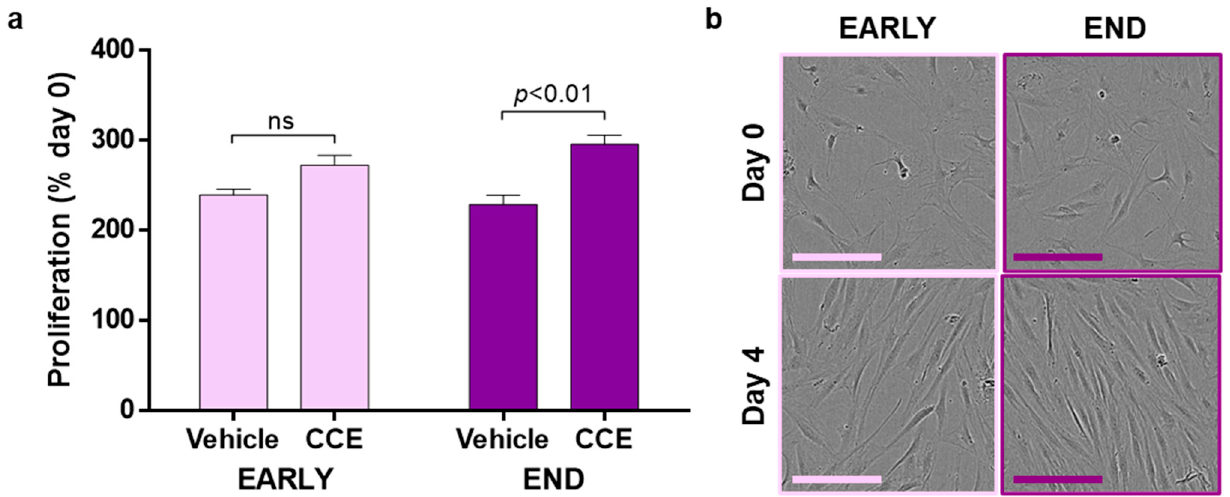
Figure 5. Paracrine modulation of hSMC proliferation. ( a ) CM from EARLY and END SMC were applied to naïve hSMC. Cultures were supplemented with 1% FBS, and proliferation was measured over 4 days. ( b ) Representative images; scale bar = 100 µm; n = 4, paired t -test. ns: not significant.